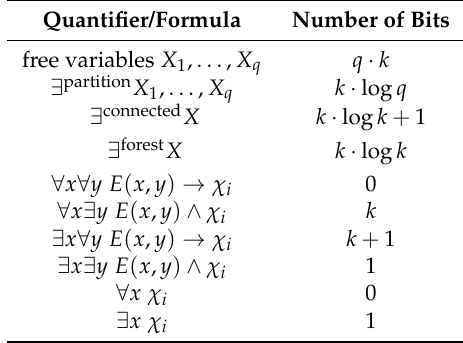
Table 1. The table shows the precise number of bits we reserve in the description of a state of the tree automaton for different quantifiers and formulas. The values are with respect to a tree decomposition with maximum bag size k